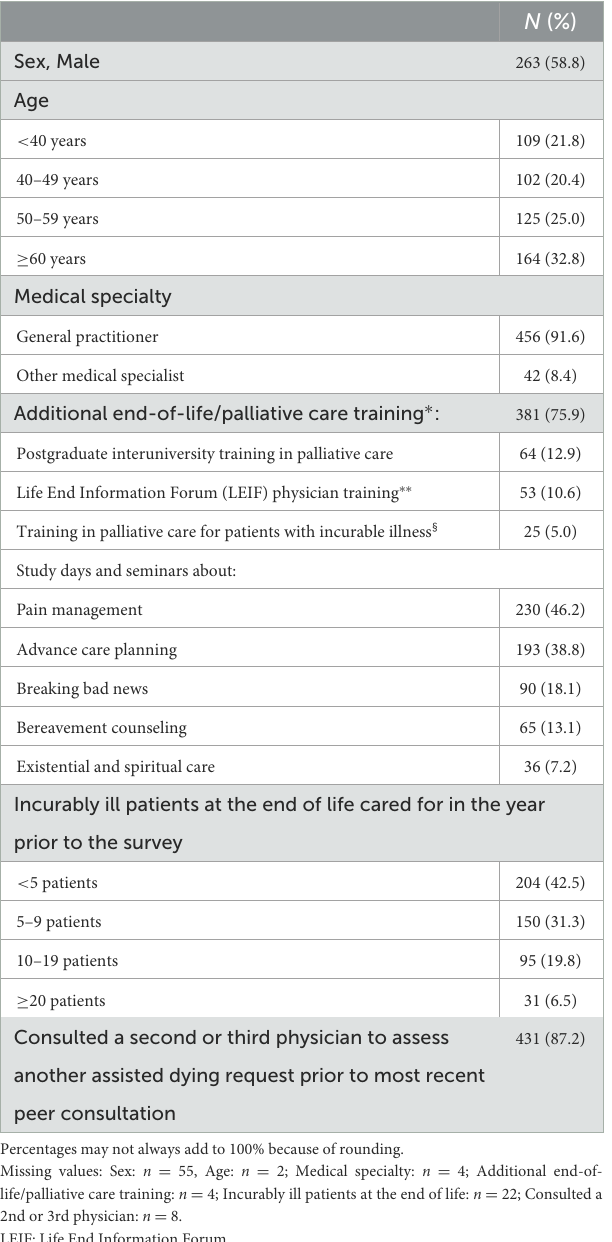
TABLE 2 Characteristics of persons requesting assisted dying (patients) and of their requests ( N =